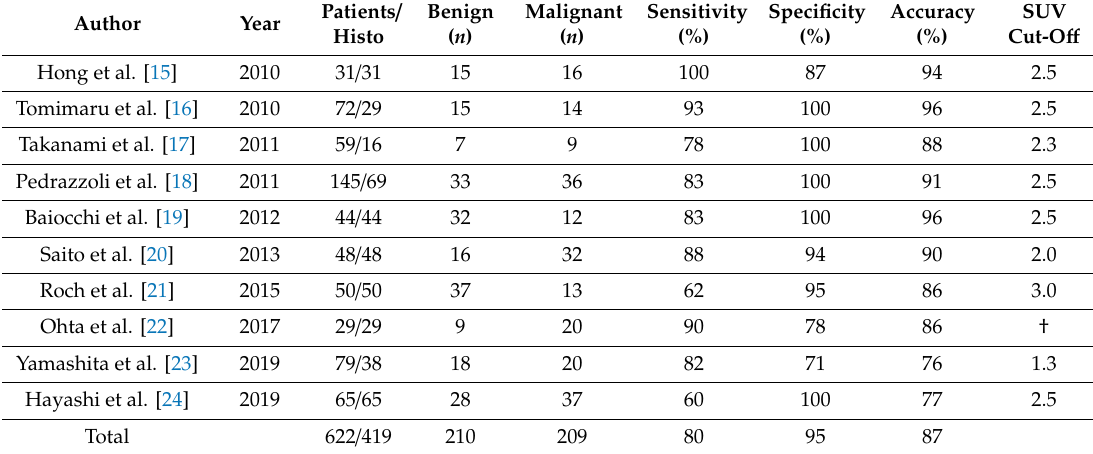
Table 2. Summary of 18-FDG-PET results for Intraductal Papillary Mucinous Neoplasm. Tot: number of patients analyzed; Histo: number of patients with histopathological diagnosis available;